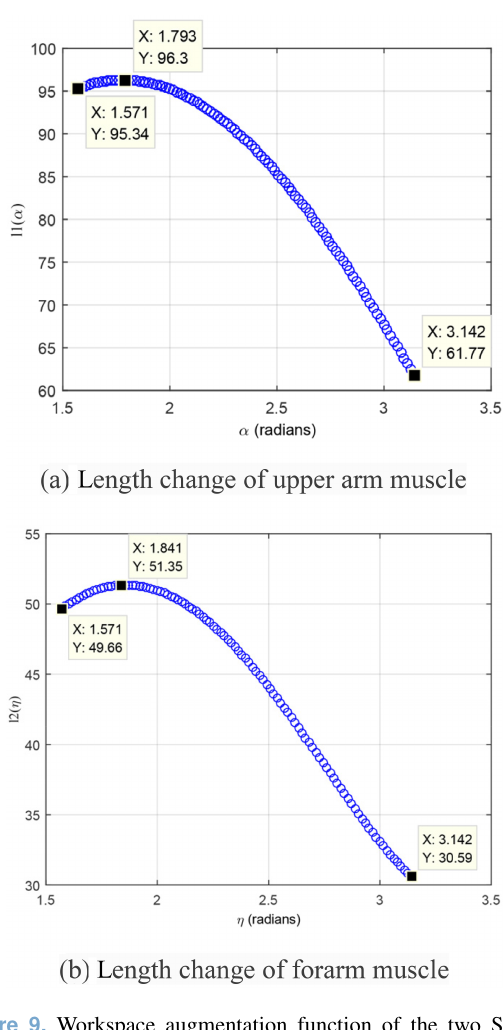
Figure 9. Workspace augmentation function of the two Sarrus- linkage-based